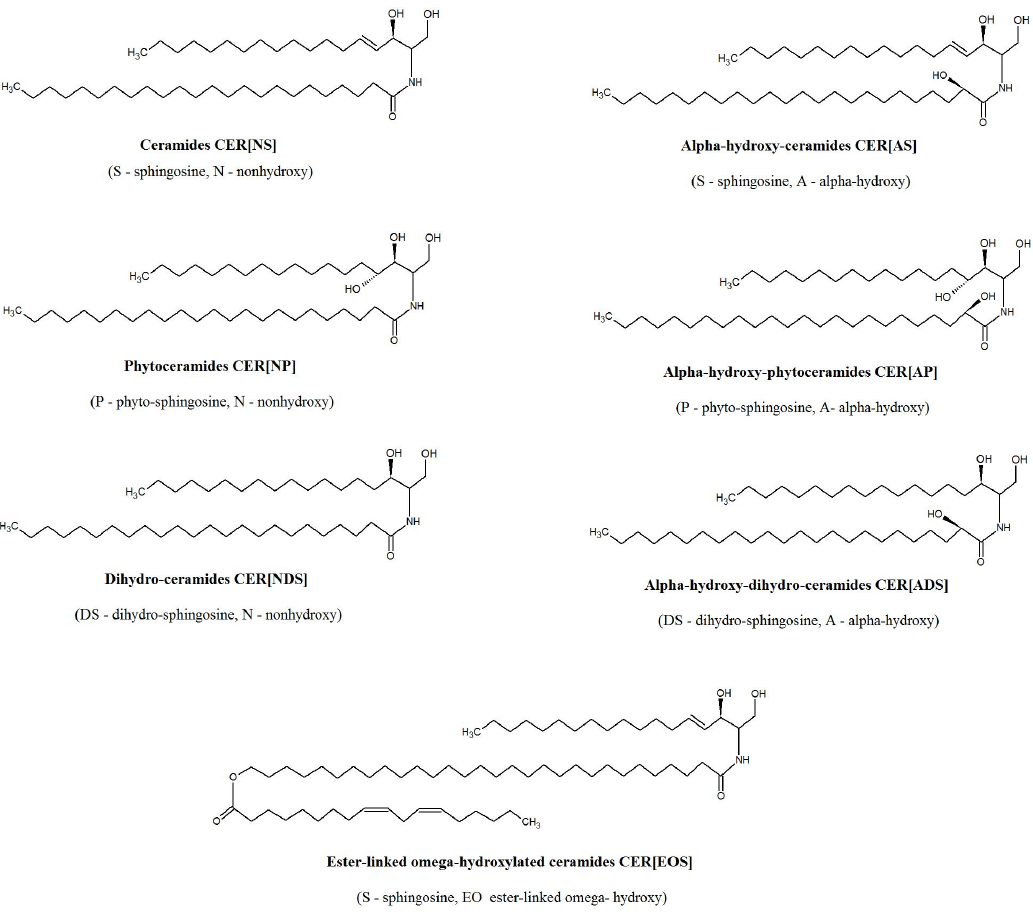
Figure 1. Major subclasses of ceramides present in epidermis.